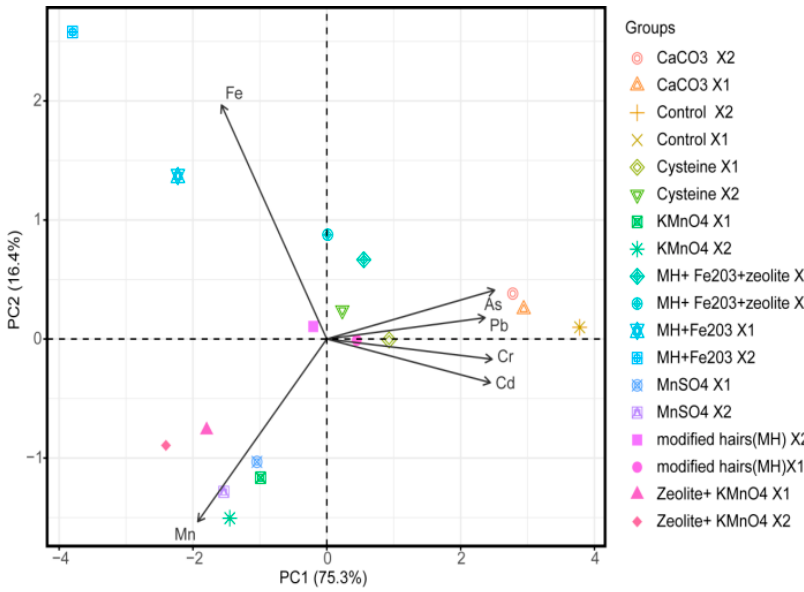
Figure 1. Principal component analysis of total element’s concentration in rice plants. PC: Principal Components.